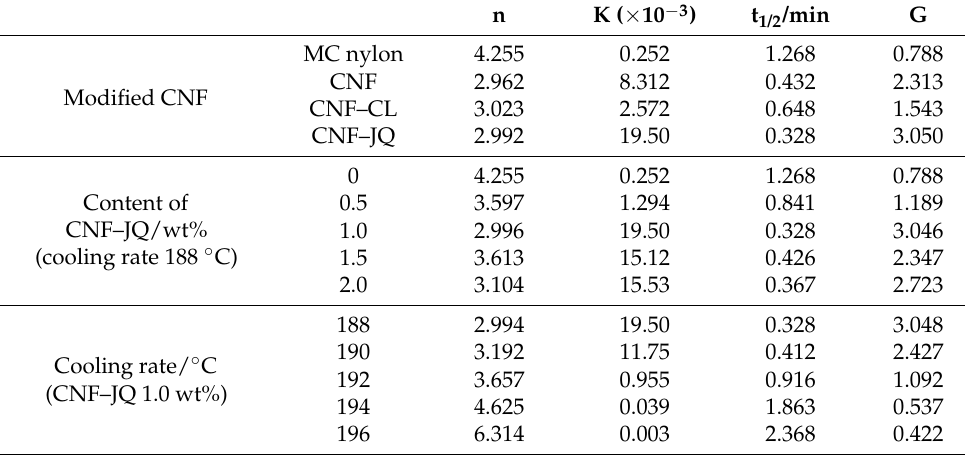
Table 2. Kinetic parameters of isothermal crystallization of MC nylon and modified CNF/MC nylon composites.